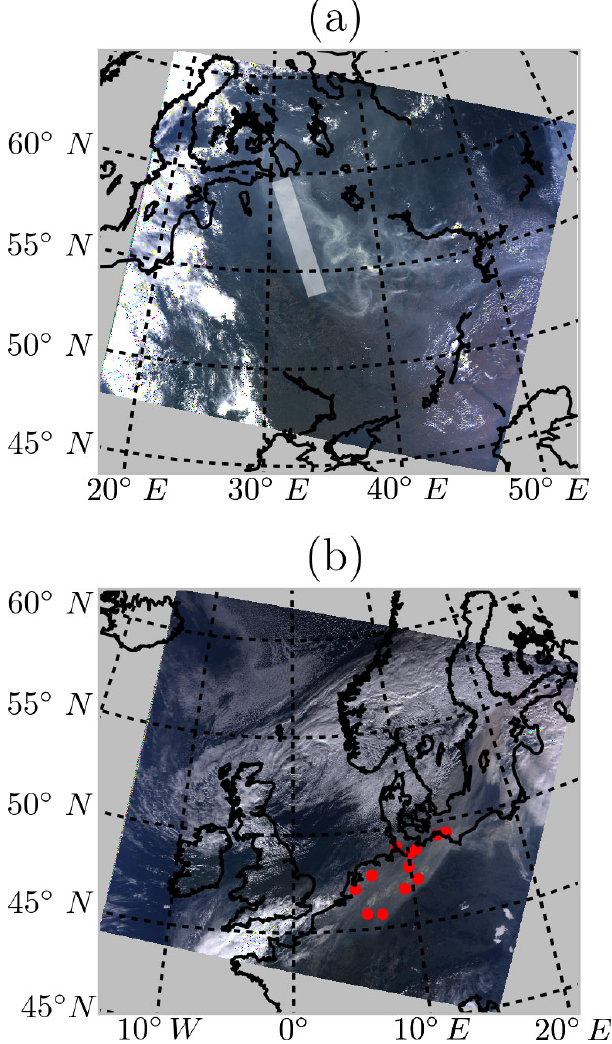
Figure 3. MODIS Terra images of the two test cases. (a) MODIS RGB composite on 08:50UTC, 8 August 2010 of the 2010 Rus- sian wildfires. The white line represents an approximation of CALIPSO’s ground track. (b) Portugal wildfire plume observed by MODIS Terra on 11:00UTC over western Europe on 17 Oc- tober 2017. Blue dots represent 12 ceilometer